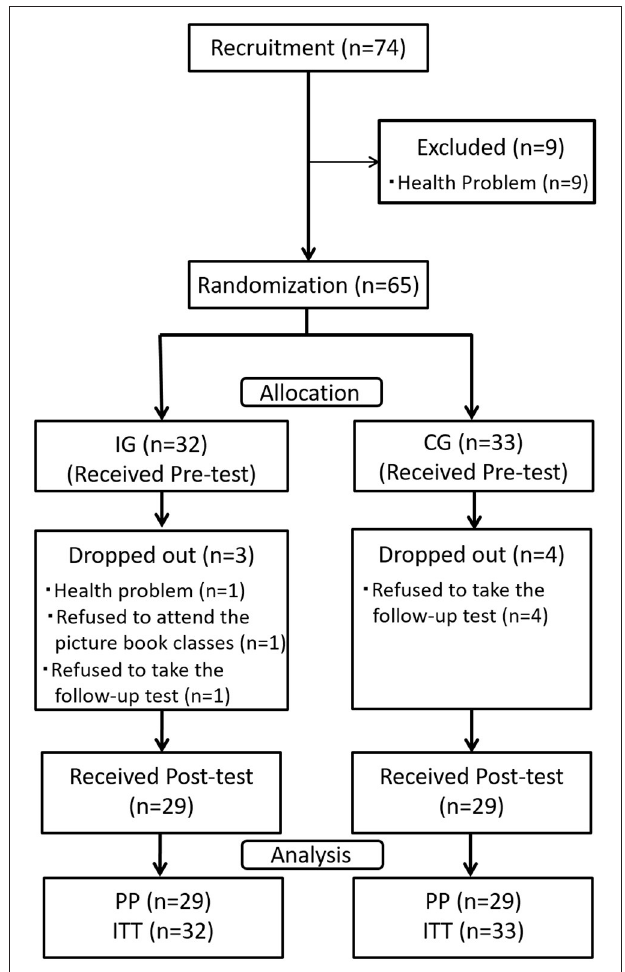
FIGURE 1 | Consolidated standards of reporting trials (CONSORT) flow diagram of the study process. N , number of participants; ITT, intent-to-treat analysis; IG, intervention group; CG, active control group; PP, Per-protocol